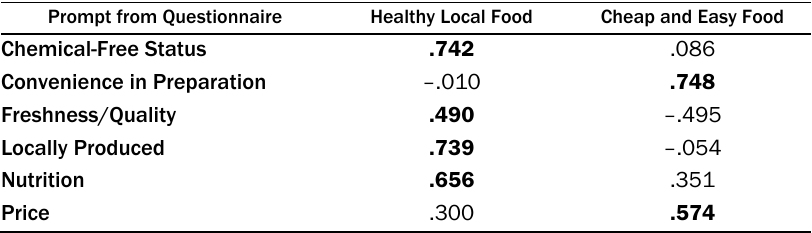
Table 3. Principle-component Analysis (PCA) Results of Six Variables Affecting Food Purchasing